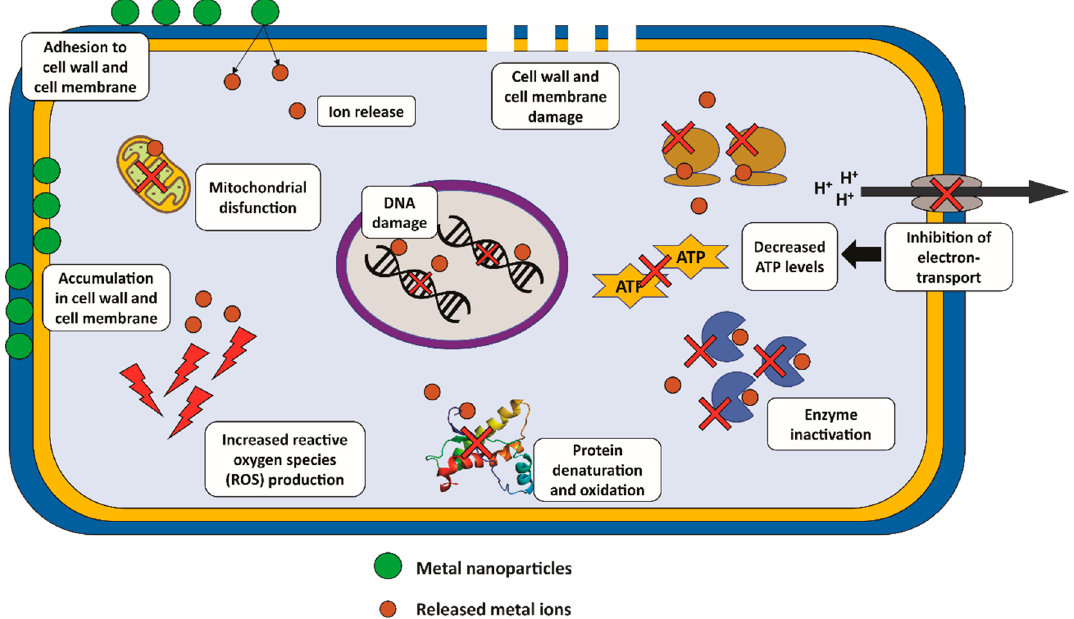
Figure 2. Main mechanisms of action of metallic nanoparticles against C. albicans. Metal nanoparticles exhibit activity against C. albicans by metal ion release, adhesion, accumulation and damage to the cell wall and cell membrane, inhibition of electron-transport with consequent reduction in ATP levels, enzyme inactivation, protein oxidation and denaturation, increased production of reactive oxygen species (ROS), mitochondria dysfunction, and DNA damage.